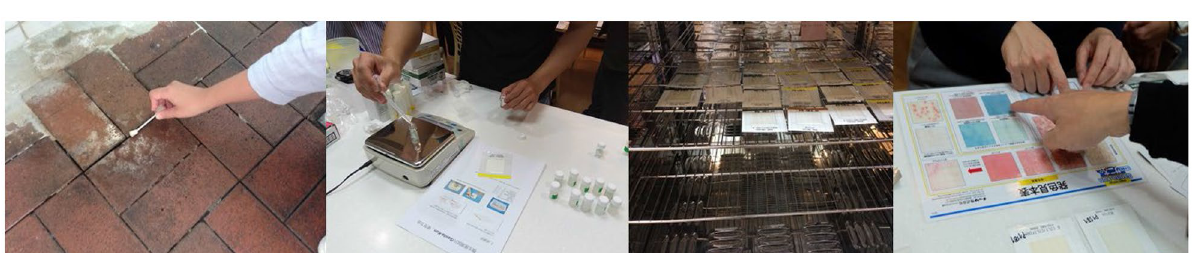
Figure 2. The sampling point of the trash can.